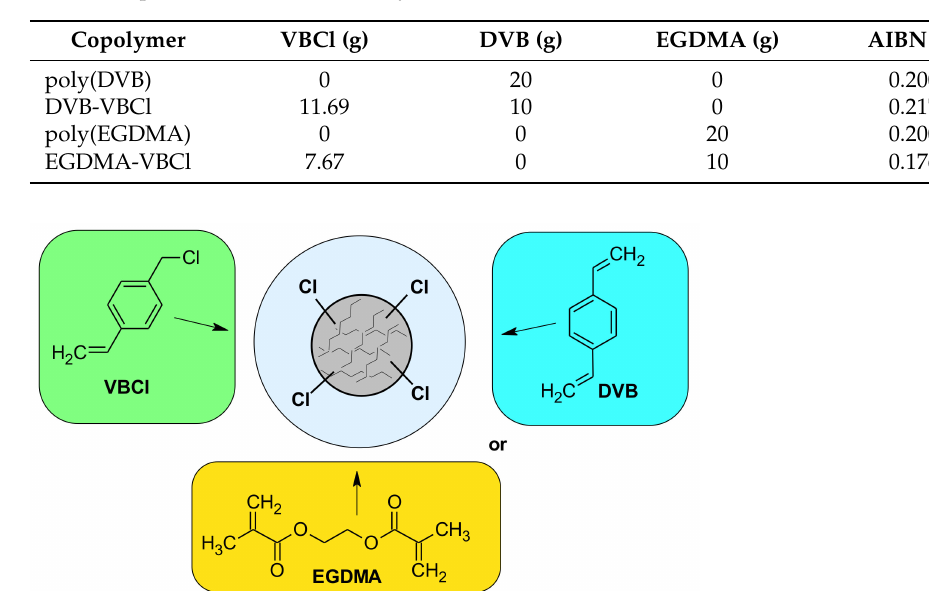
Table 1. Experimental conditions of synthesis.